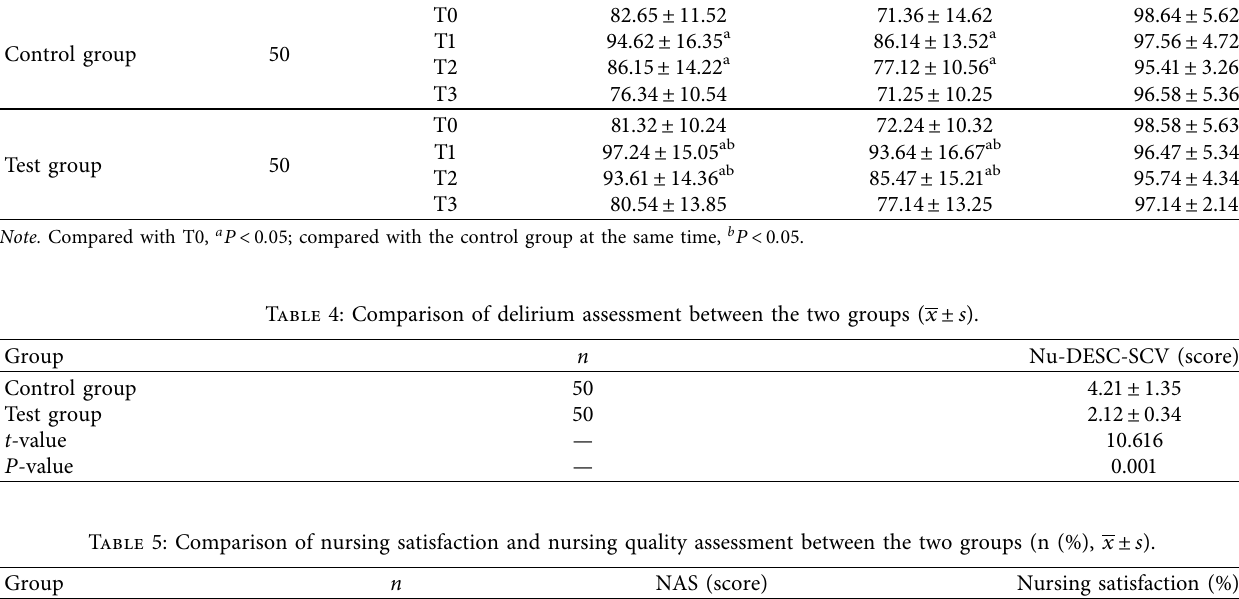
Table 3: Comparison of vital signs between two groups of patients at diferent time periods ( x ± s ). Group